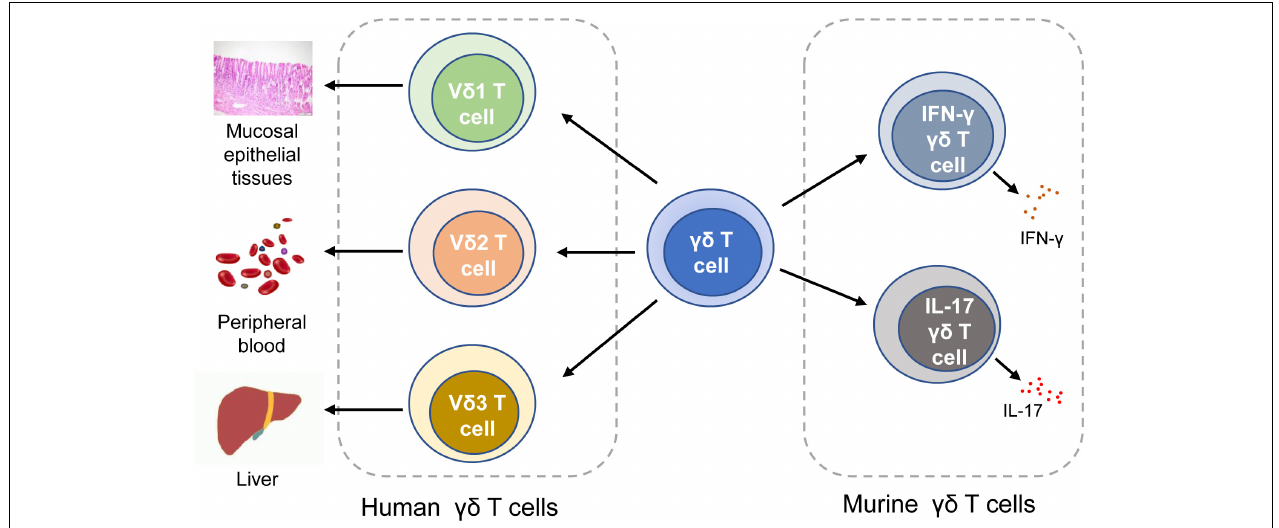
FIGURE 1 | Classification of γδ T cells. In human, γδ T cells can be classified into V δ 1 T cells, V δ 1 T cells, and V δ 3 T cells. In mice, γδ T cells can be categorized into IFN- γ γδ T cells and IL-17 γδ T cells. IFN- γ , interferon- γ